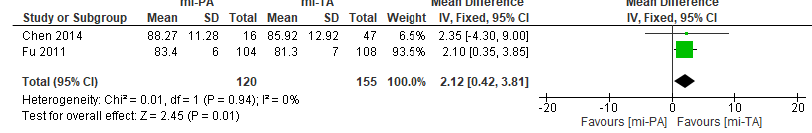
( g ) Forest plot representing analysis of postoperative DBP (mmHg).